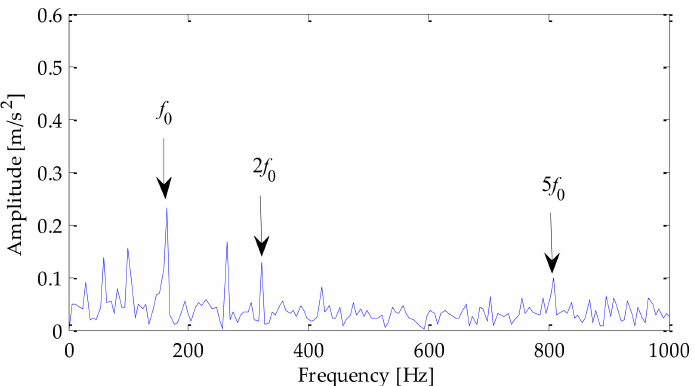
Figure 30. Analysis of signal envelope spectrum after noise reduction based on LMD–RobustICA.